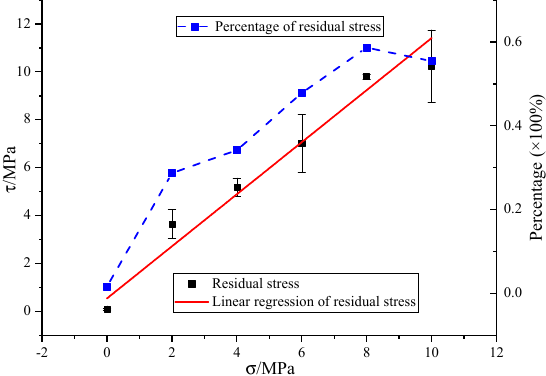
Figure 9. Relationship between residual stress and axial pressure.